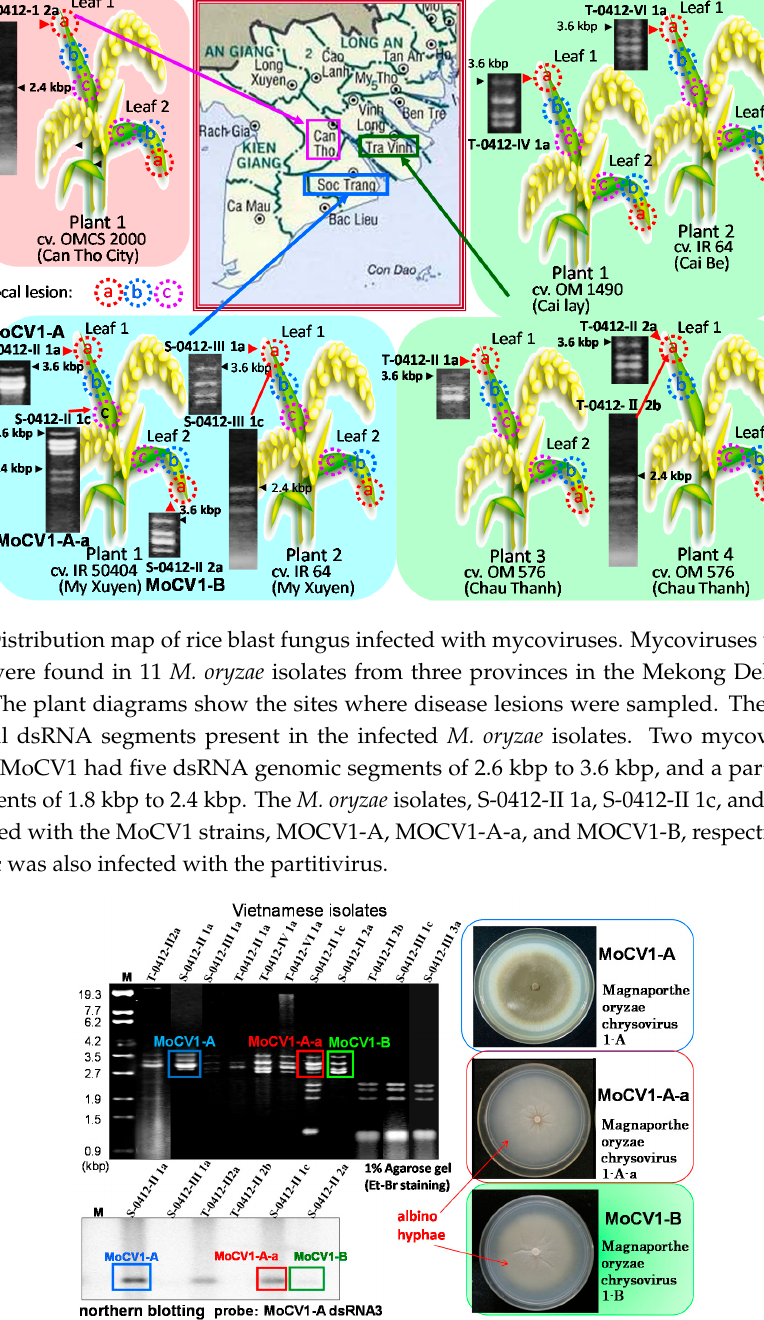
Figure 2. Analysis of mycoviruses isolated from M. oryzae in Vietnam. Top left, agarose gel electrophoresis of dsRNAs derived from mycoviruses purified from rice blast isolates. Lower left, northern hybridisation with a cDNA probe derived from MoCV1-A dsRNA3, showing a weak signal for MoCV1-B dsRNA3. Right, fungal flora of the M. oryzae isolates infected with MoCV1-A (top), MoCV1-A-a (middle), and MoCV1-B (bottom). These isolates were cultured on PDA medium at 26 ◦ C for 10